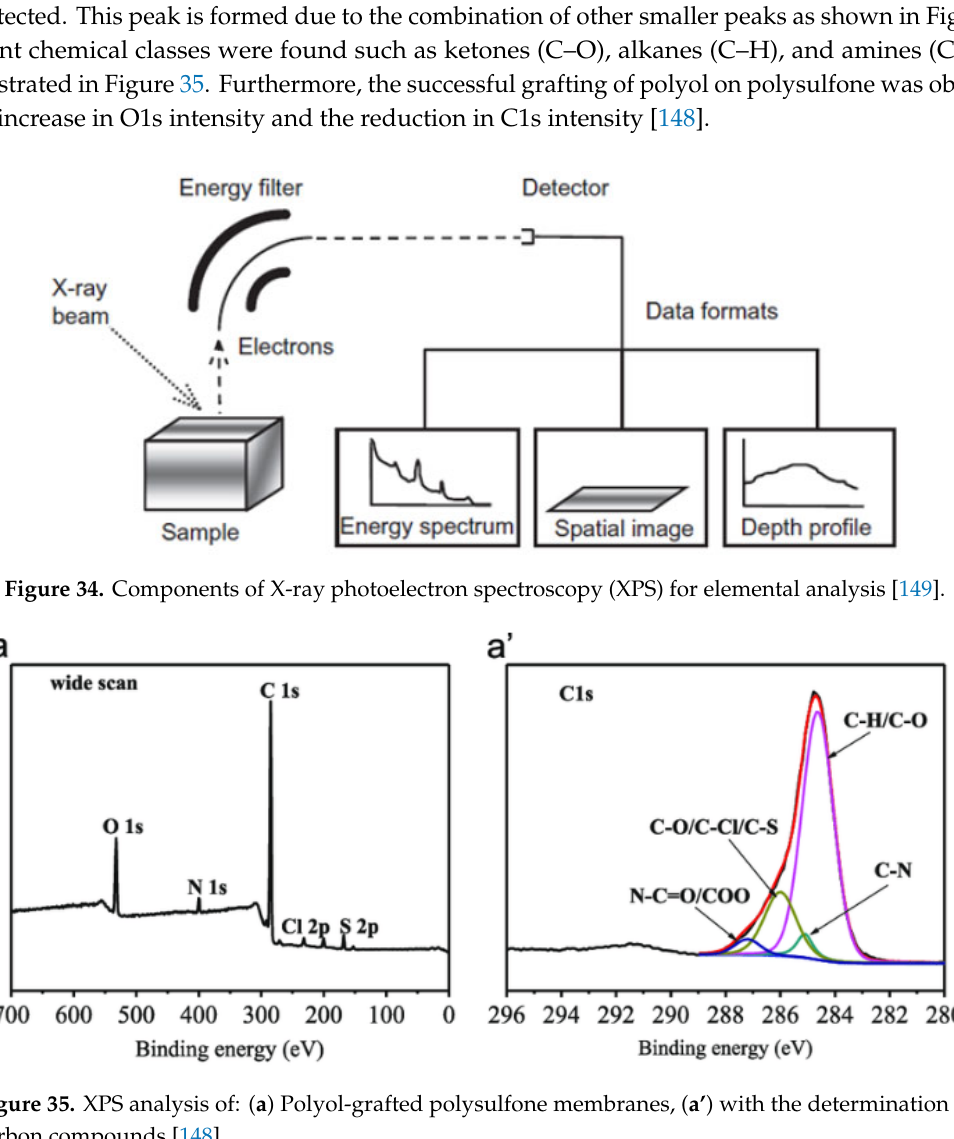
Figure 35. XPS analysis of: ( a ) Polyol-grafted polysulfone membranes, ( a’ ) with the determination of carbon compounds [148]. Table 12. Studies for membrane characterization by XPS.